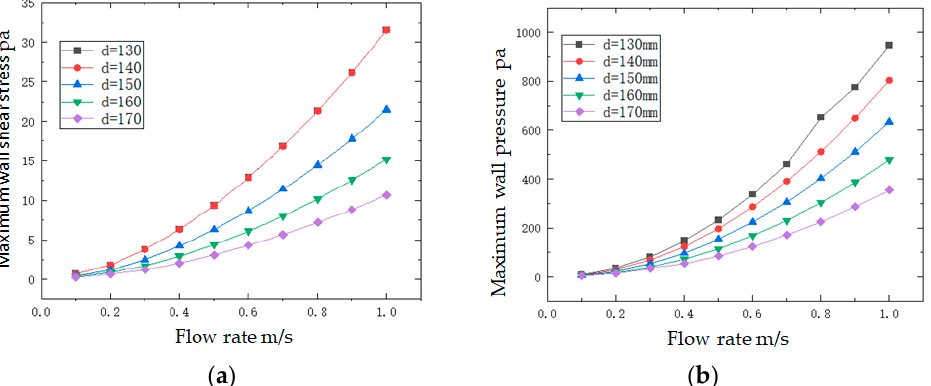
Figure 12. The influence of flow rate on the erosion of the reducer; ( a ) Trend of maximum wall shear stress; ( b ) Trend of maximum wall pressure. stress; ( b ) Trend of maximum wall